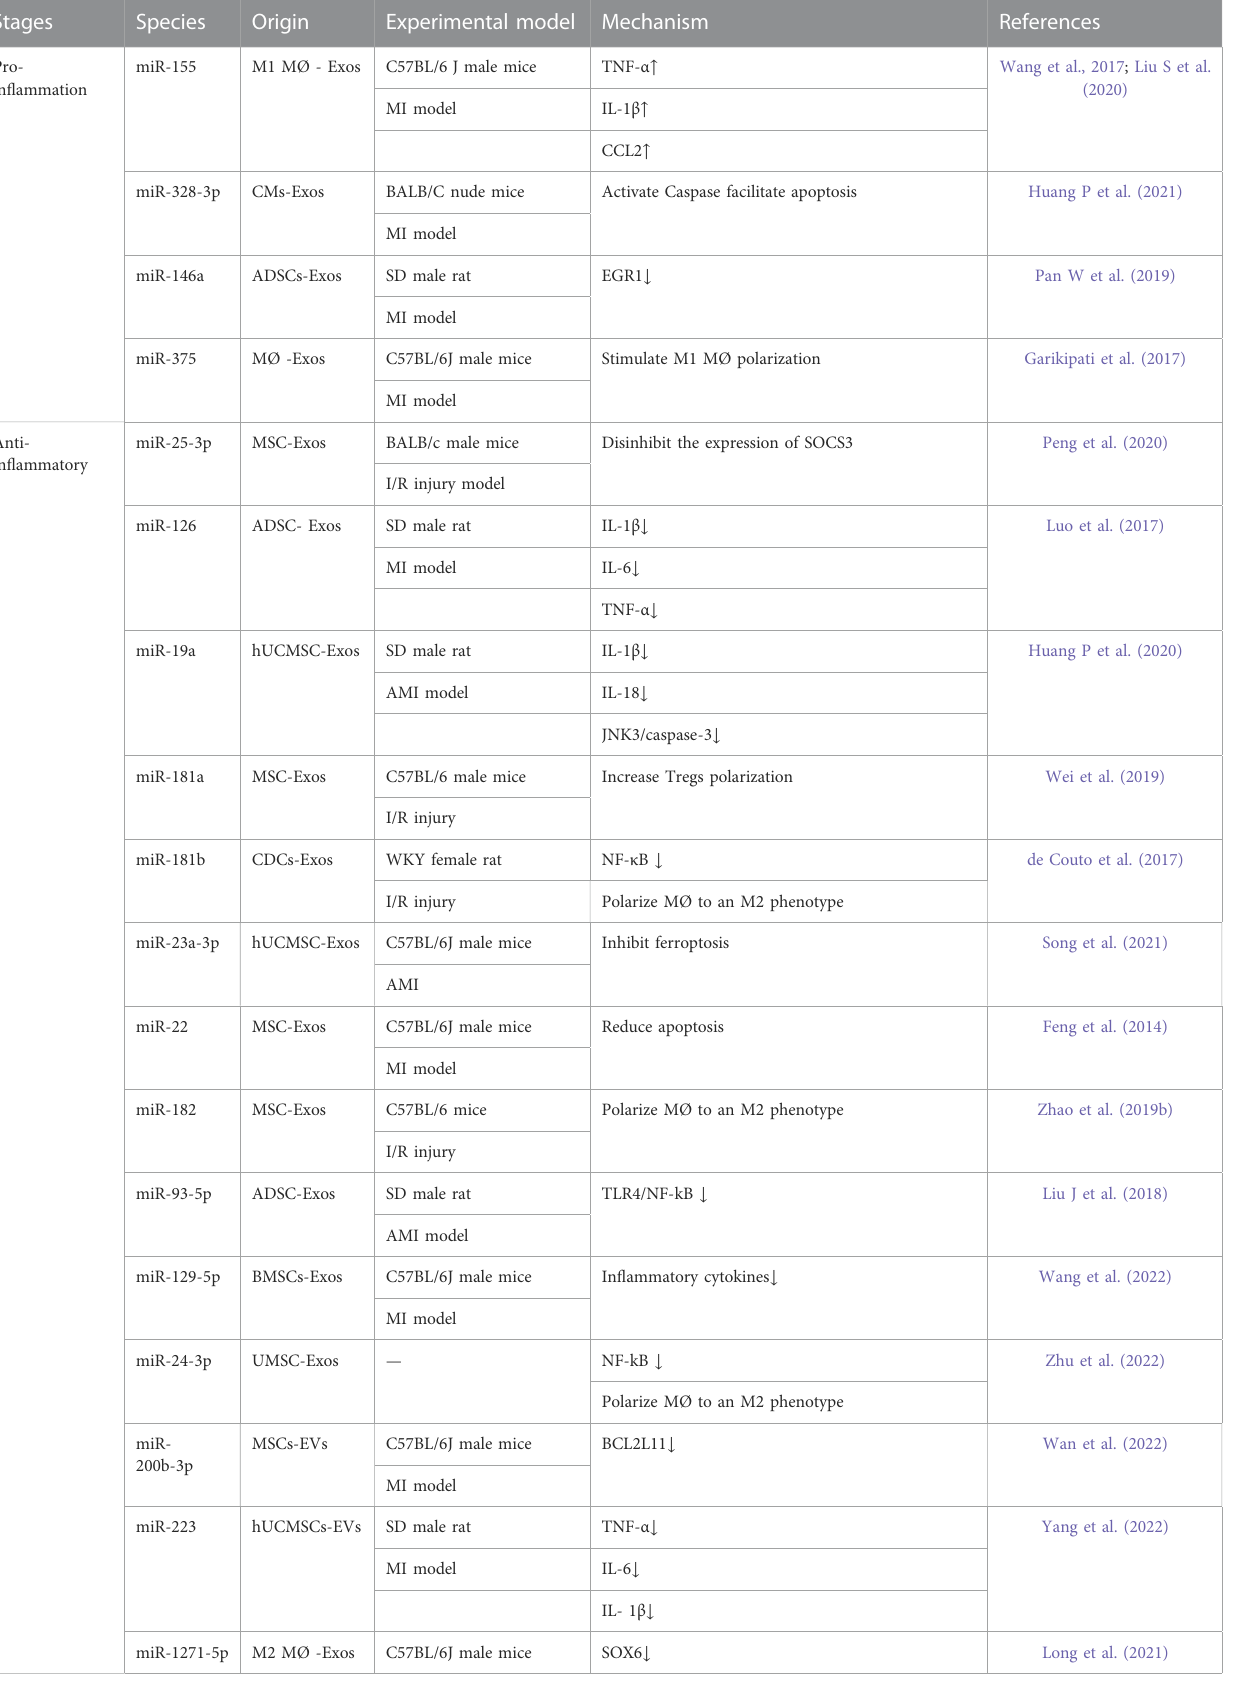
TABLE 1 Speci fi c application and mechanism of miRNAs carried by EVs in post-infarction cardiac